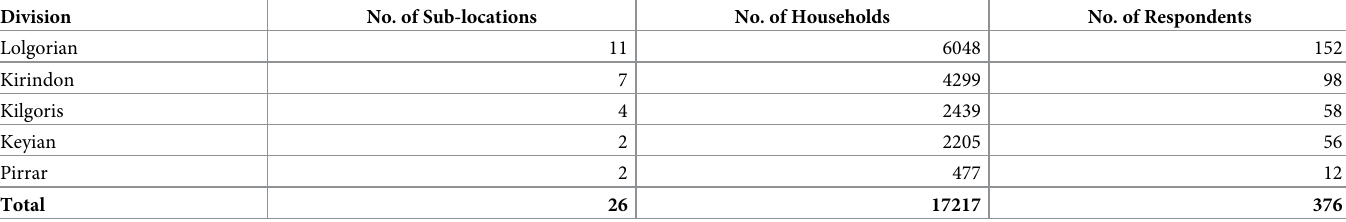
Table 1. Distribution of samples from each